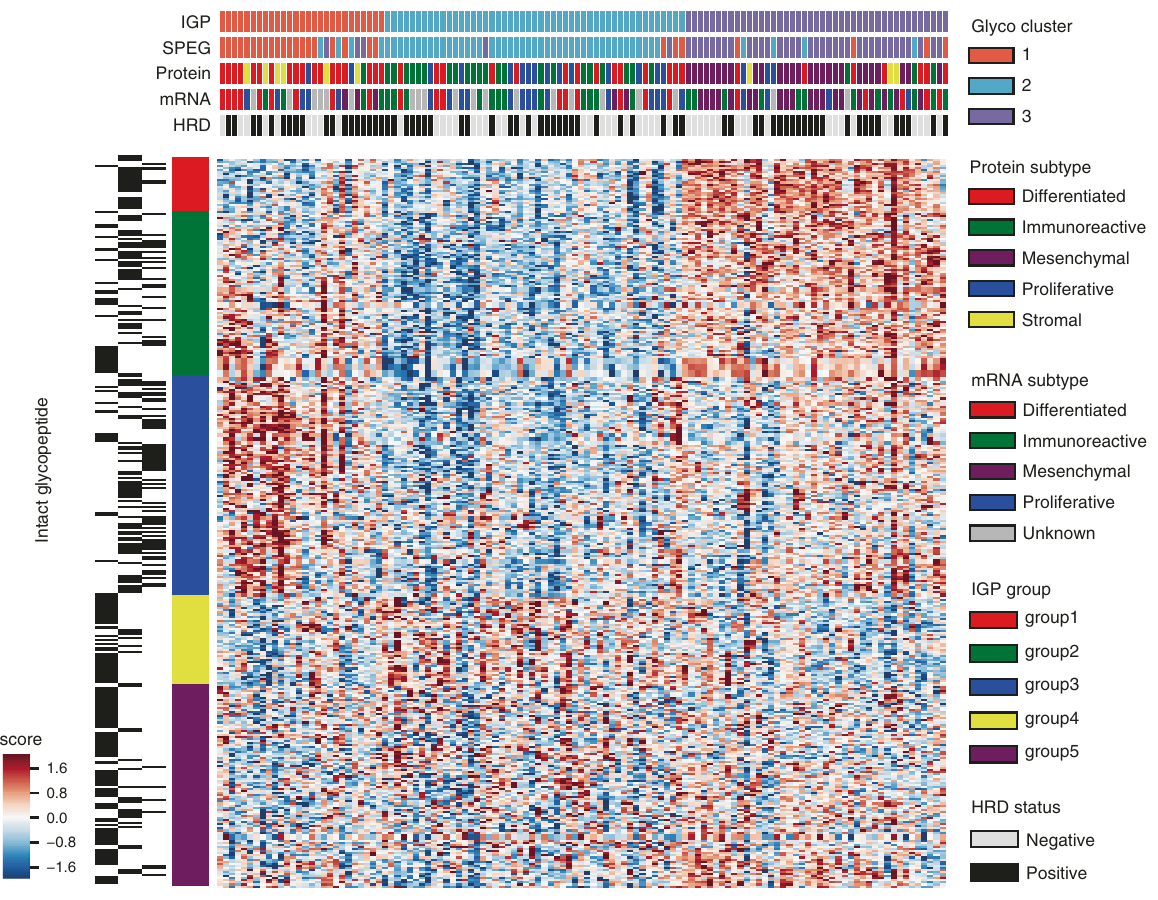
Fig. 1 Clustering analysis of high-grade serous ovarian carcinoma based on glycoproteomics data. Bi-clustering of intact glycopeptide expression in 119 tumor tissues. Tumors are displayed as columns, grouped by intact glycopeptide clusters as indicated by different colors. Intact glycopeptides used for the tumor classi fi cation are displayed as rows with glycans shown in the right heatmap. Color of each cell indicates Z score (log2 of relative abundance scaled by intact glycopeptide standard deviations) of the intact glycopeptide in that sample. Transcriptome, proteomic-based subtypes, HRD annotations and the proposed SPEG, IGP clusters are indicated in color above the